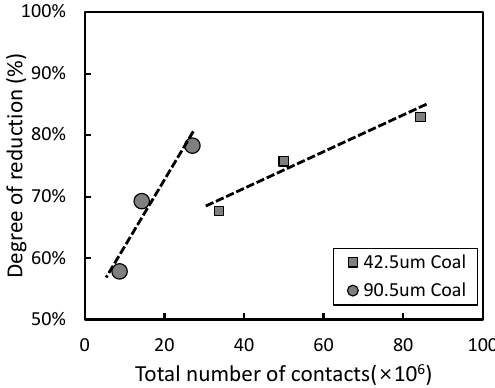
Figure 5. Relationship of the degree of reduction and the number of contacts.